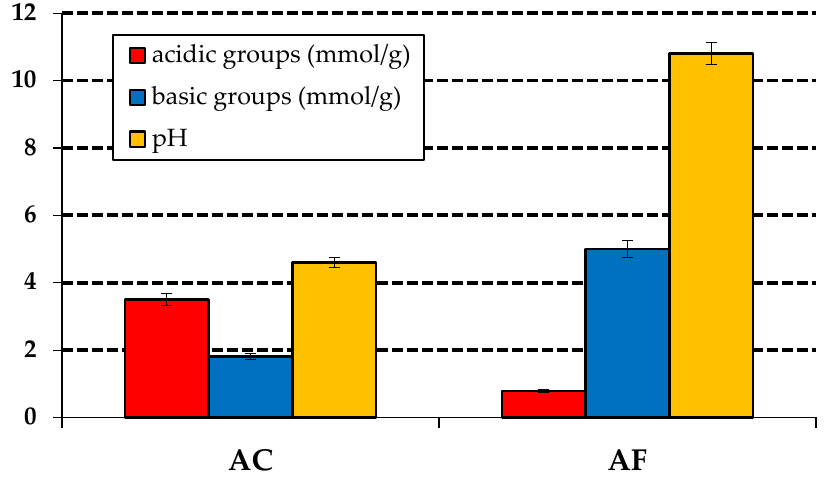
Figure 2. Acid-base properties of the activated carbons.